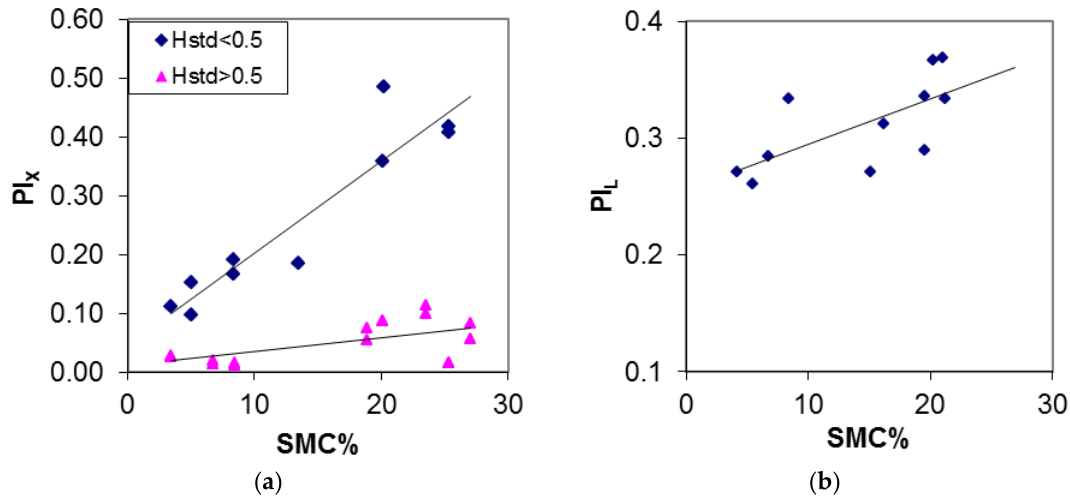
Figure 3. ( a ) PI at X band (PI X ) vs. SMC for 2 surface types; ( b ) PI at L band (PI L ) vs. SMC.